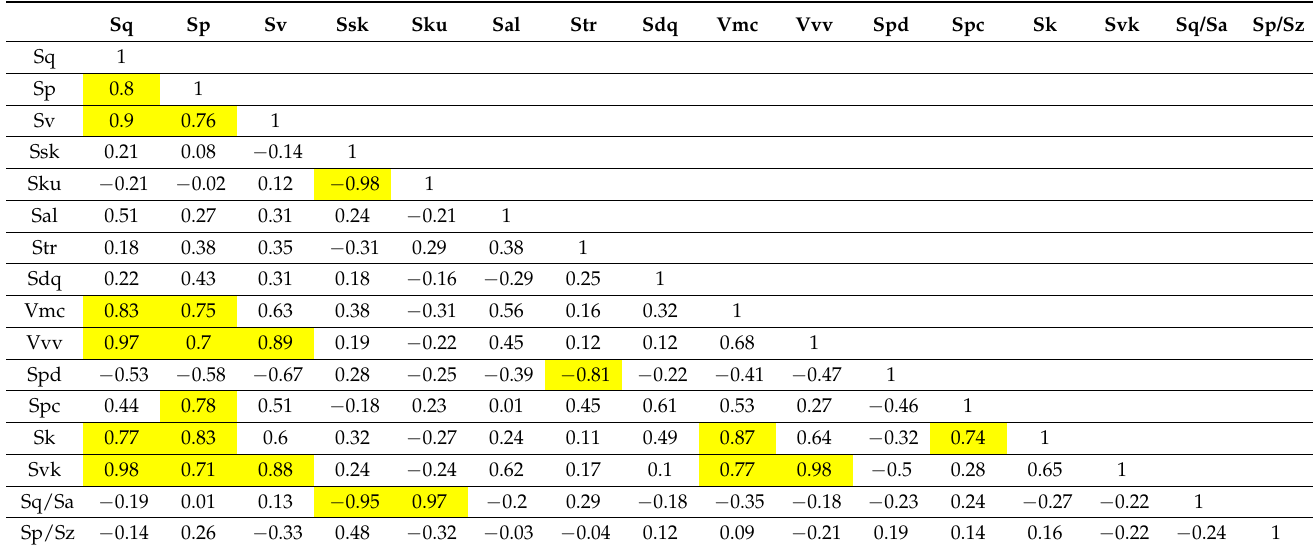
Table 4. Coefficients of linear correlation between selected parameters of the textured surfaces, the strong correlations are marked by yellow